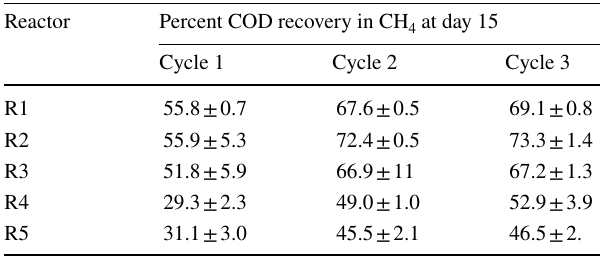
Table 5 Average of percent COD recovery as methane during the successive cycles